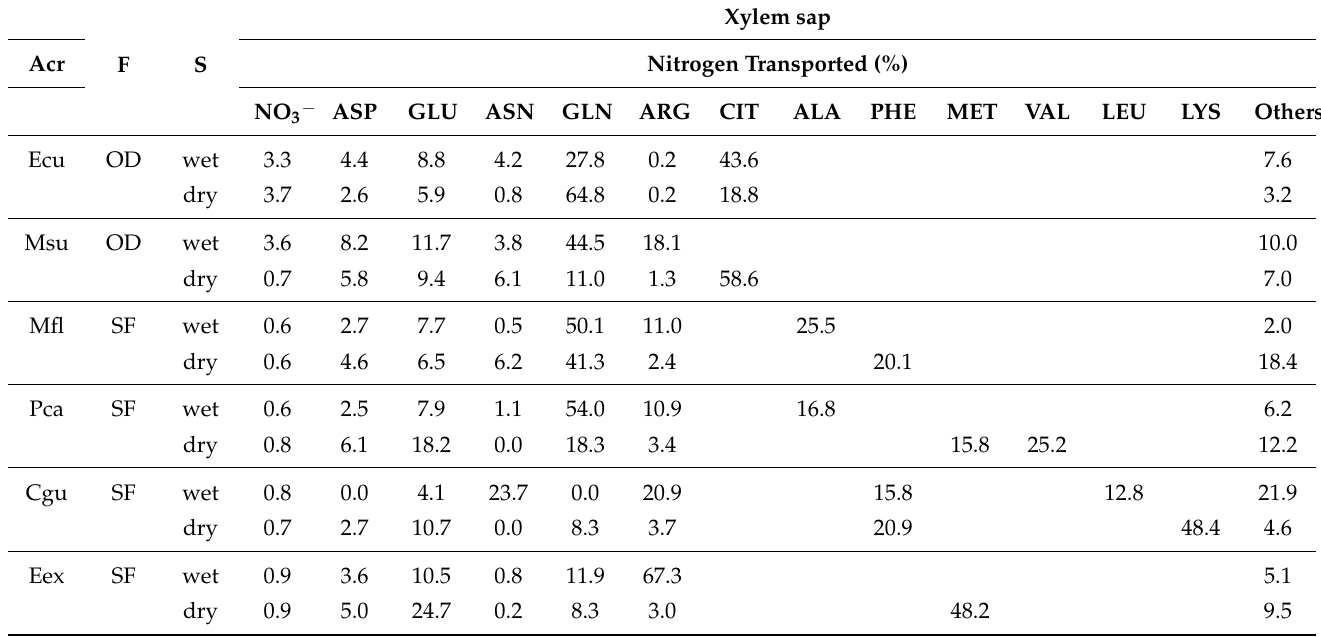
Table 4. Amino acid concentration (AA) and N transport in xylem sap of the Myrtaceae tree species during the wet and dry seasons. ASP = Aspartate, GLU = Glutamate, ASN = Asparagine, GLN = Glutamine, ARG = Arginine, CIT, Citruline, ALA = Alanine, PHE = Phenylalanine, MET = Methionine, VAL = Valine, LEU = Leucine, LYS = Lysine, Others = sum of remaining amino acids (each below 10%). Data are mean values. Acr—the species acronym, F—Forest type, S—Season. Types of tropical forest: OD—Ombrophylous Dense and SF—Semideciduous. Xylem sap Nitrogen Transported